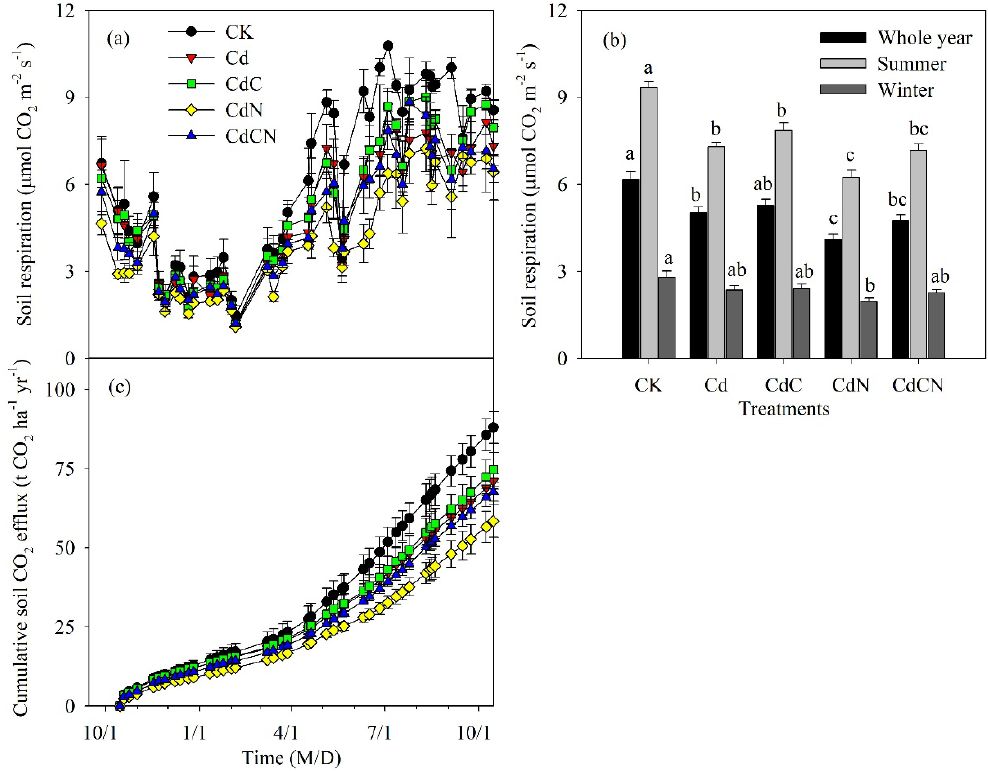
Figure 4. Seasonal variations of soil respiration ( a ); mean soil respiration rate for the whole year, the summer, and the winter ( b ); and cumulative CO 2 efflux ( c ) as affected by five treatments: CK (the control; with ambient Cd, ambient CO 2 , and ambient N deposition); Cd (with Cd addition, ambient CO 2 , and ambient N deposition); CdC (with Cd addition, elevated CO 2 , and ambient N deposition); CdN (with Cd addition, N addition, and ambient CO 2 ); and CdCN (with Cd addition, elevated CO 2 , and N addition). Vertical lines represent the standard error of the mean ( n = 3). Within the same period, means with different letters are significantly different ( p < 0.05) based on repeated measures ANOVA.